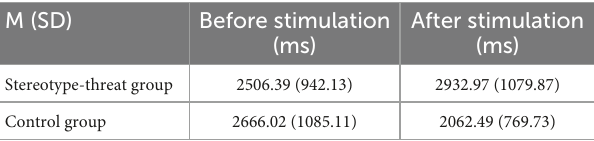
TABLE 2 Reaction times at different stages of the mental rotation task in both groups of participants. M